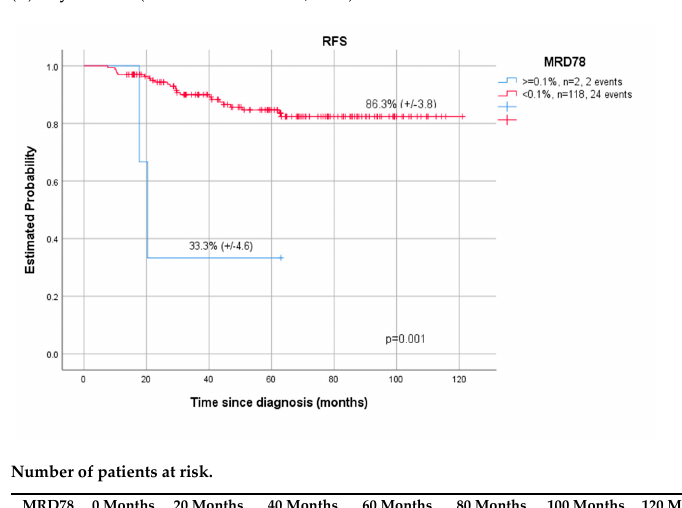
Number of patients at risk.